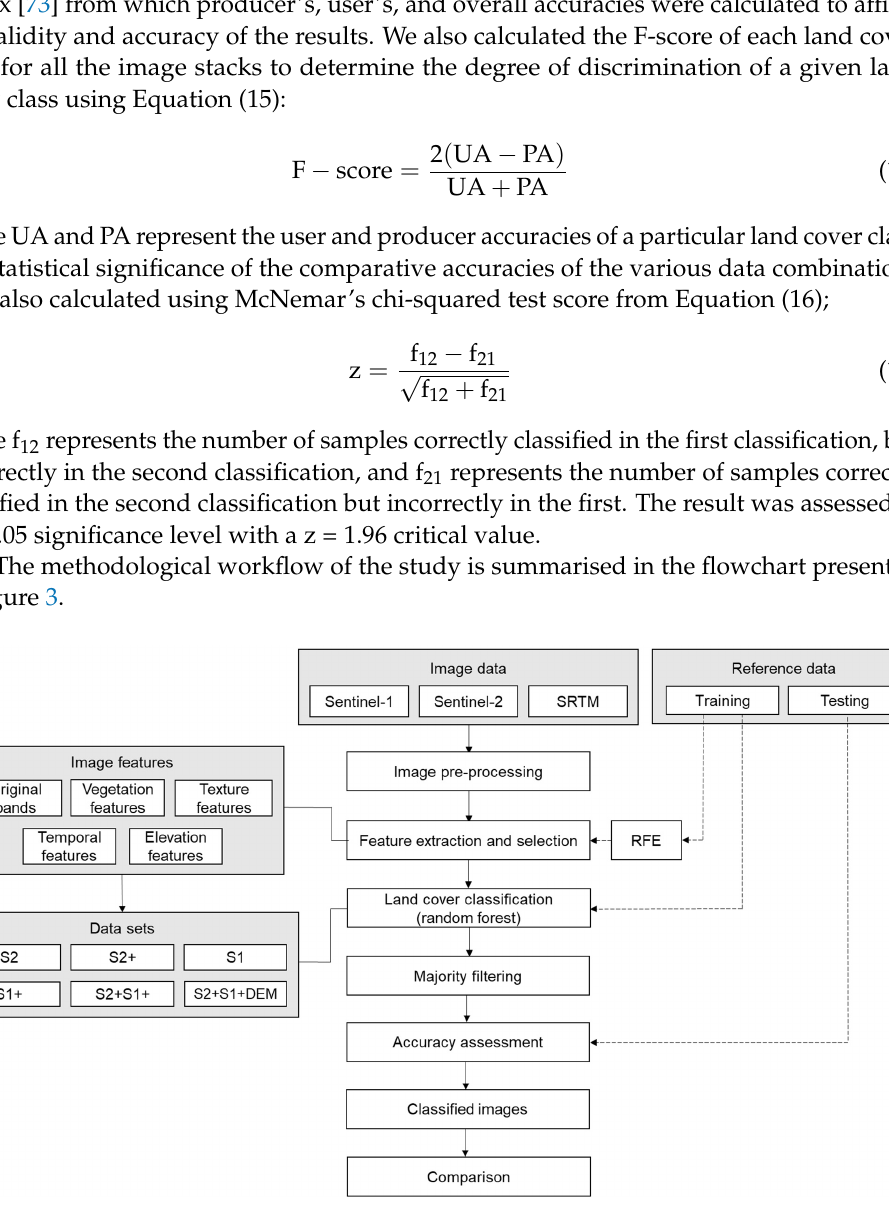
Figure 3. Process flowchart for land cover classification of Greater Amanzule using individual and integrated Sentinel-2, Sentinel-1 and SRTM datasets.